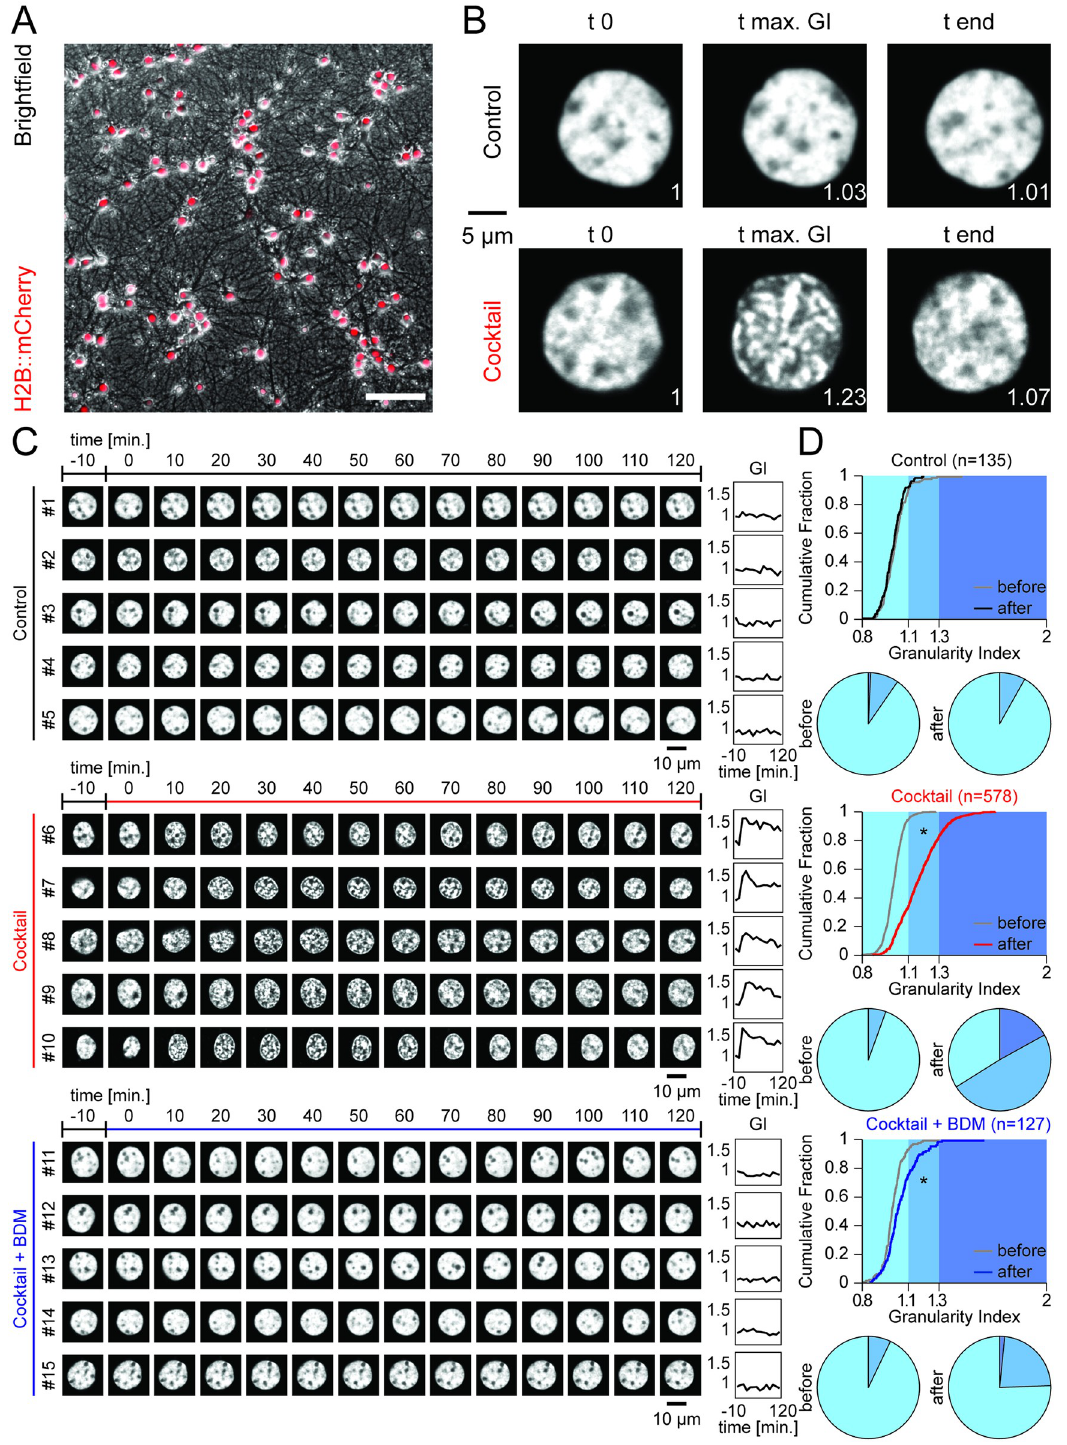
Fig 1. Transient reorganization of chromatin structure upon pharmacological induction of neuronal activity in primary cortical neurons. ( A ) Culture of primary cortical neurons expressing H2B::mCherry. Scale: 100 μ m. ( B ) Confocal images of two nuclei labeled with H2B::mCherry during a time lapse experiment. Top: Incubation with standard medium. Bottom: Incubation with pharmacological cocktail. First time point (t 0), time point of maximal Granularity Index (t max. GI), and last time point (t end). The corresponding GI value normalized to t 0 is shown on the bottom right of each image. ( C ) Time lapse images of example nuclei labeled with H2B::mCherry (Treatment conditions: Control, black; cocktail, red; cocktail+BDM, blue). Colored line on top